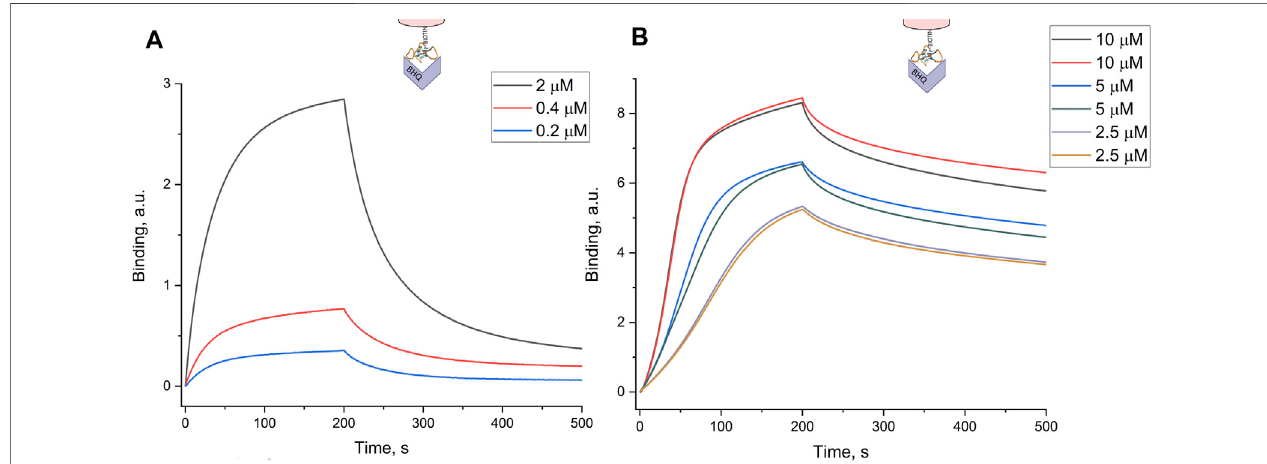
FIGURE 5 | Binding of the BHQ-2 amine to the aptamer RHA0385 estimated by biolayer interferometry. The experiment was performed in (A) a buffer with physiological ionic strength (buffer A) and in (B) a 50x-diluted buffer (buffer B).